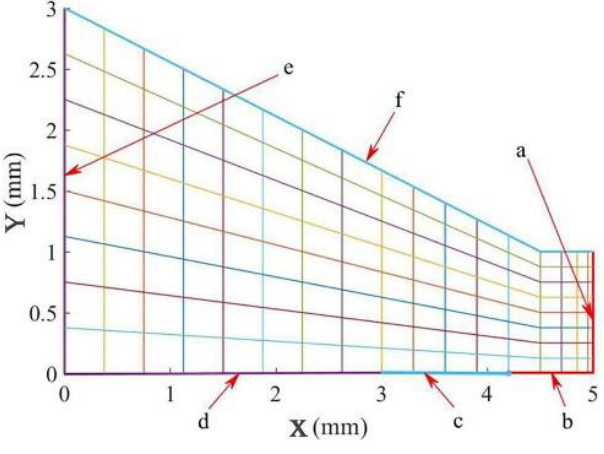
Figure 10. The boundaries of a